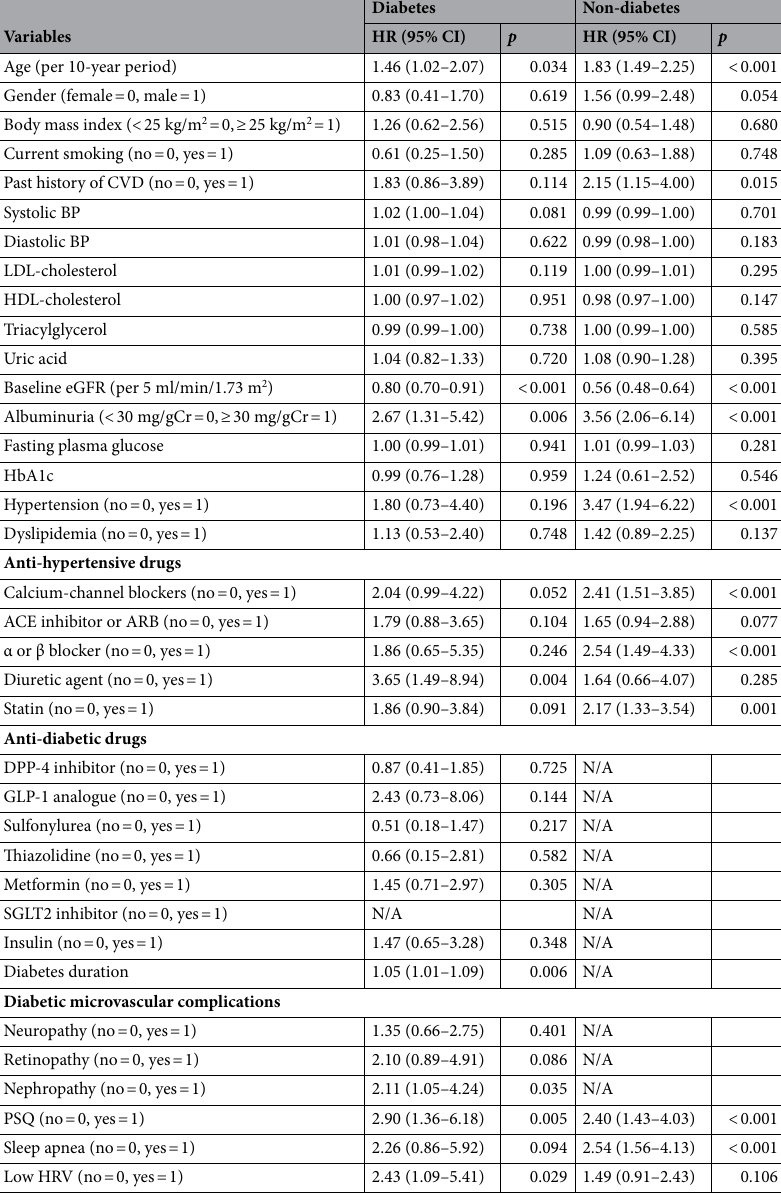
Table 2. Univariate Cox proportional analyses of the factors associated with renal outcome. DM diabetes mellitus, CVD cardiovascular disease, BP blood pressure, LDL low density lipoprotein, HDL high density lipoprotein, eGFR estimated glomerular filtration rate, ACE angiotensin converting enzyme, ARB angiotensin II receptor blocker, DPP dipeptidyl peptidase, GLP glucagon-like peptide, PSQ poor sleep quality, HRV heart rate variability, NA not applicable, HR hazard ratio, CI confidence